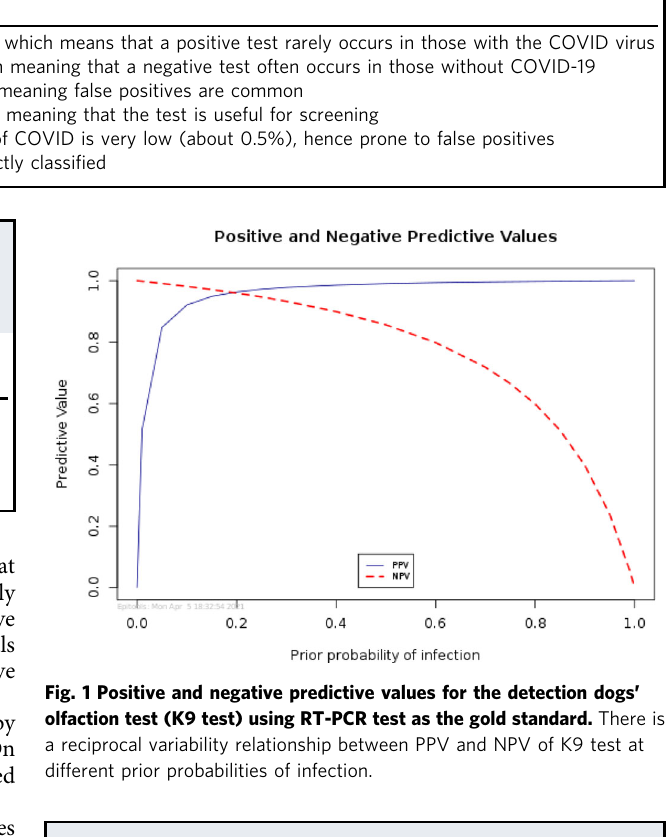
Table 4 Cross-tabulated results for combinations of two diagnostic tests K9 dogs and RT_PCR for diagnosis of COVID-19 in the human population ( n = 3134) in